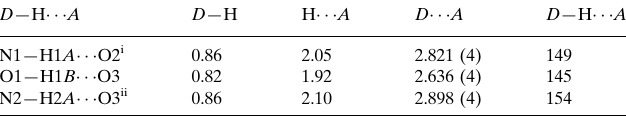
Hydrogen-bond geometry (A˚ , (cid:2)